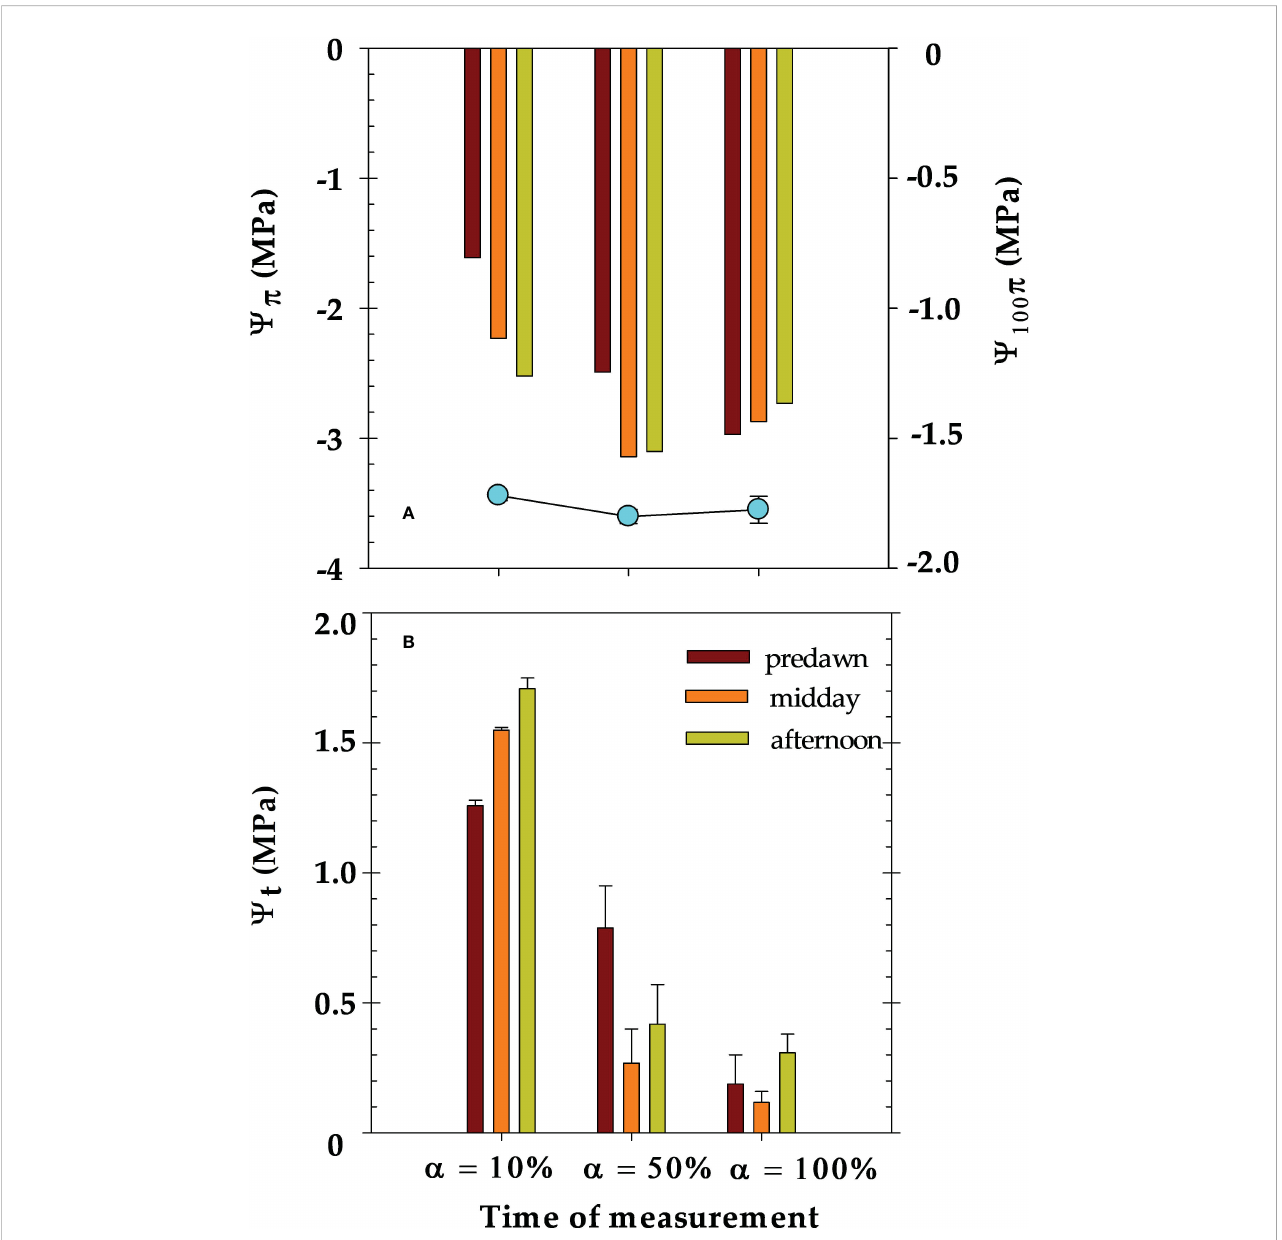
FIGURE 10 Values of: (A) actual osmotic water potential ( Y p ), and osmotic water potential at full turgor ( Y p 100 ), and (B) and leaf turgor potential ( Y t ) at different times of the day (predawn, midday and afternoon) during the different irrigation criteria: a =10% (DOY 174), a =50% (DOY 210) and a =100% (DOY 244). The measurements were made on the same leaves used for leaf water potential. Each bar is the mean of four leaves ±